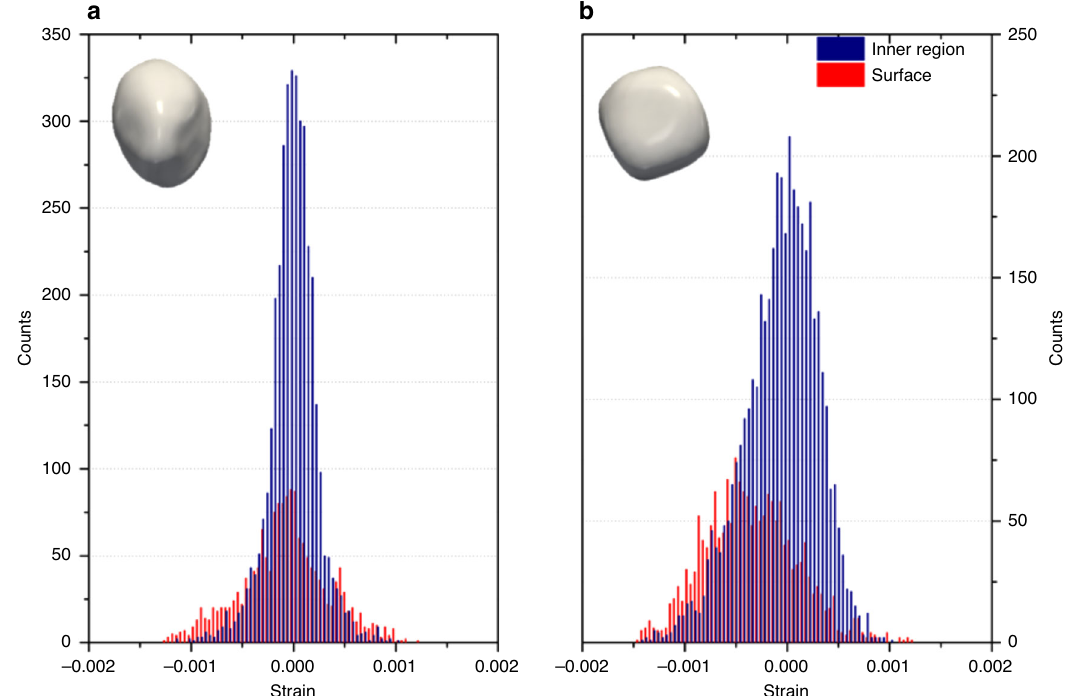
Fig. 2 Statistical distribution of strain of the calcined nanocrystals. a Gold cuboctahedron and b gold cube. The strain of the inner regions in blue of the nanocrystal is shown with the surfaces strain in red. The corresponding 3D Bragg electron density is shown in